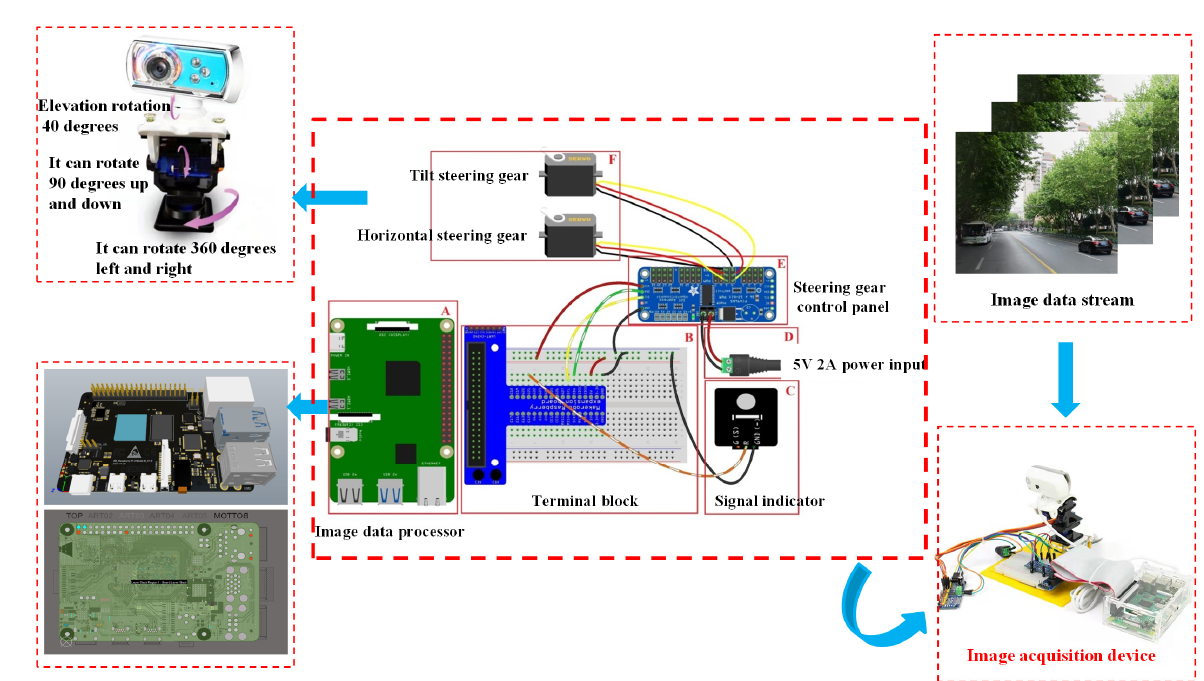
Figure 7. The visual sensor structure used in this paper.